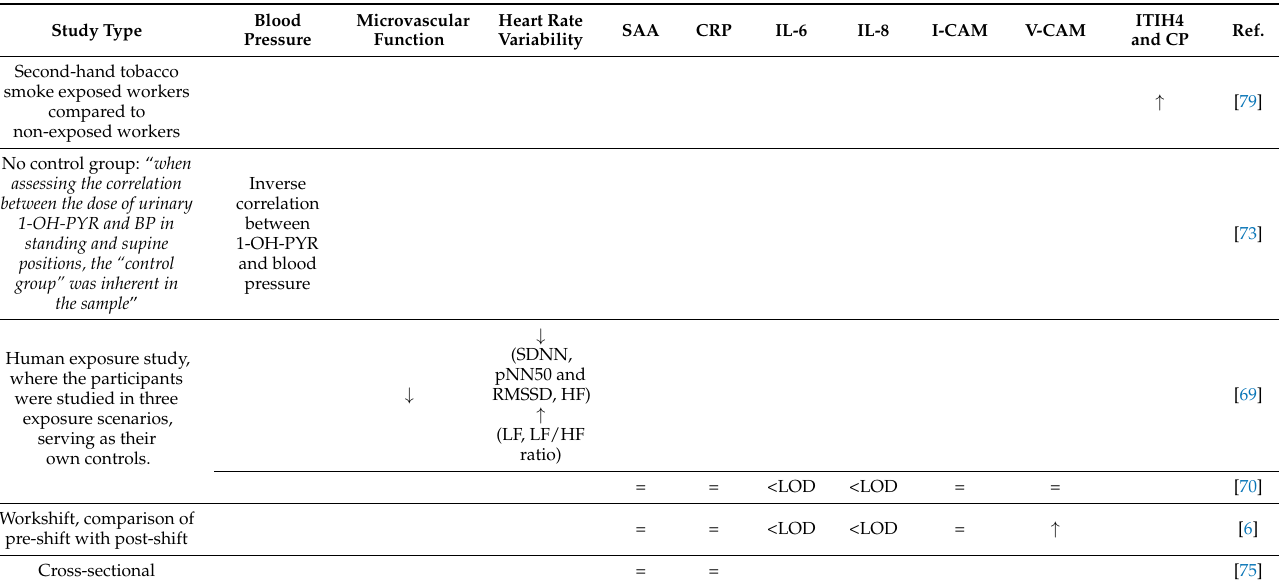
Table 6. Summary of reported effects related to cardiovascular